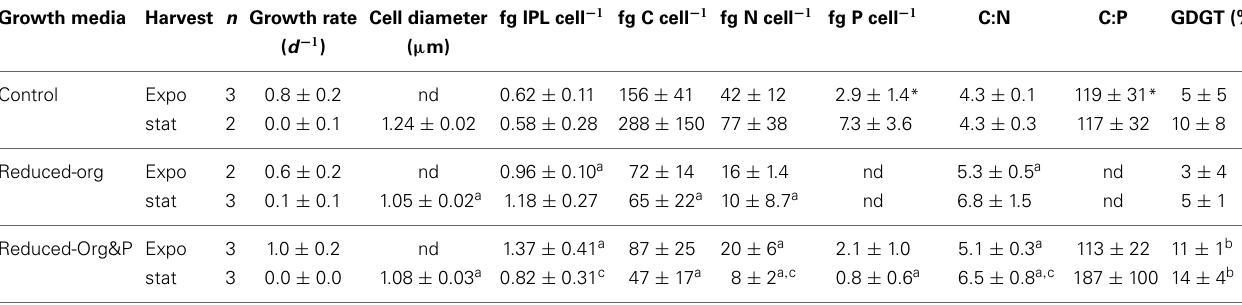
Table 1 | Average ± standard deviation of elemental and IPL compositions of T.